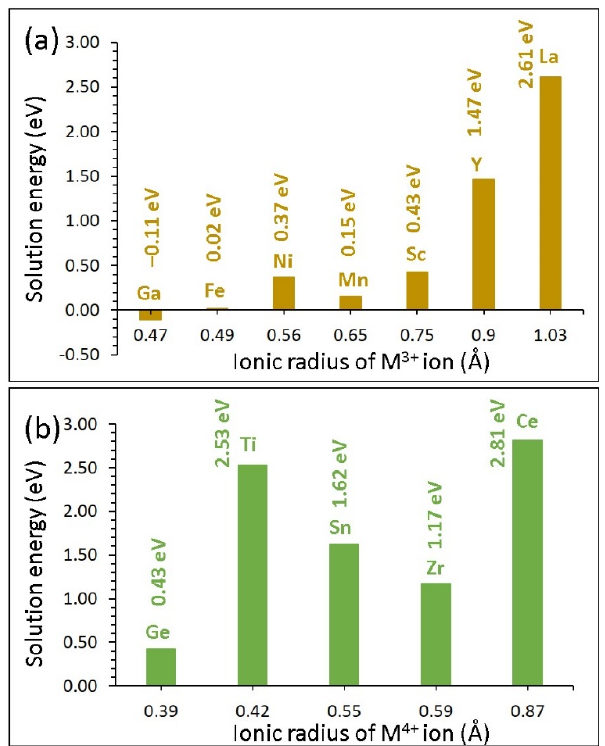
Figure 6. Solution energies of ( a ) M 2 O 3 (M = Ga, Fe, Ni, Mn, Sc, Y and La) and ( b ) MO 2 (M = Ge, Ti, Sn, Zr and Ce) with respect to their ionic radii in Al 2 SiO 5 .